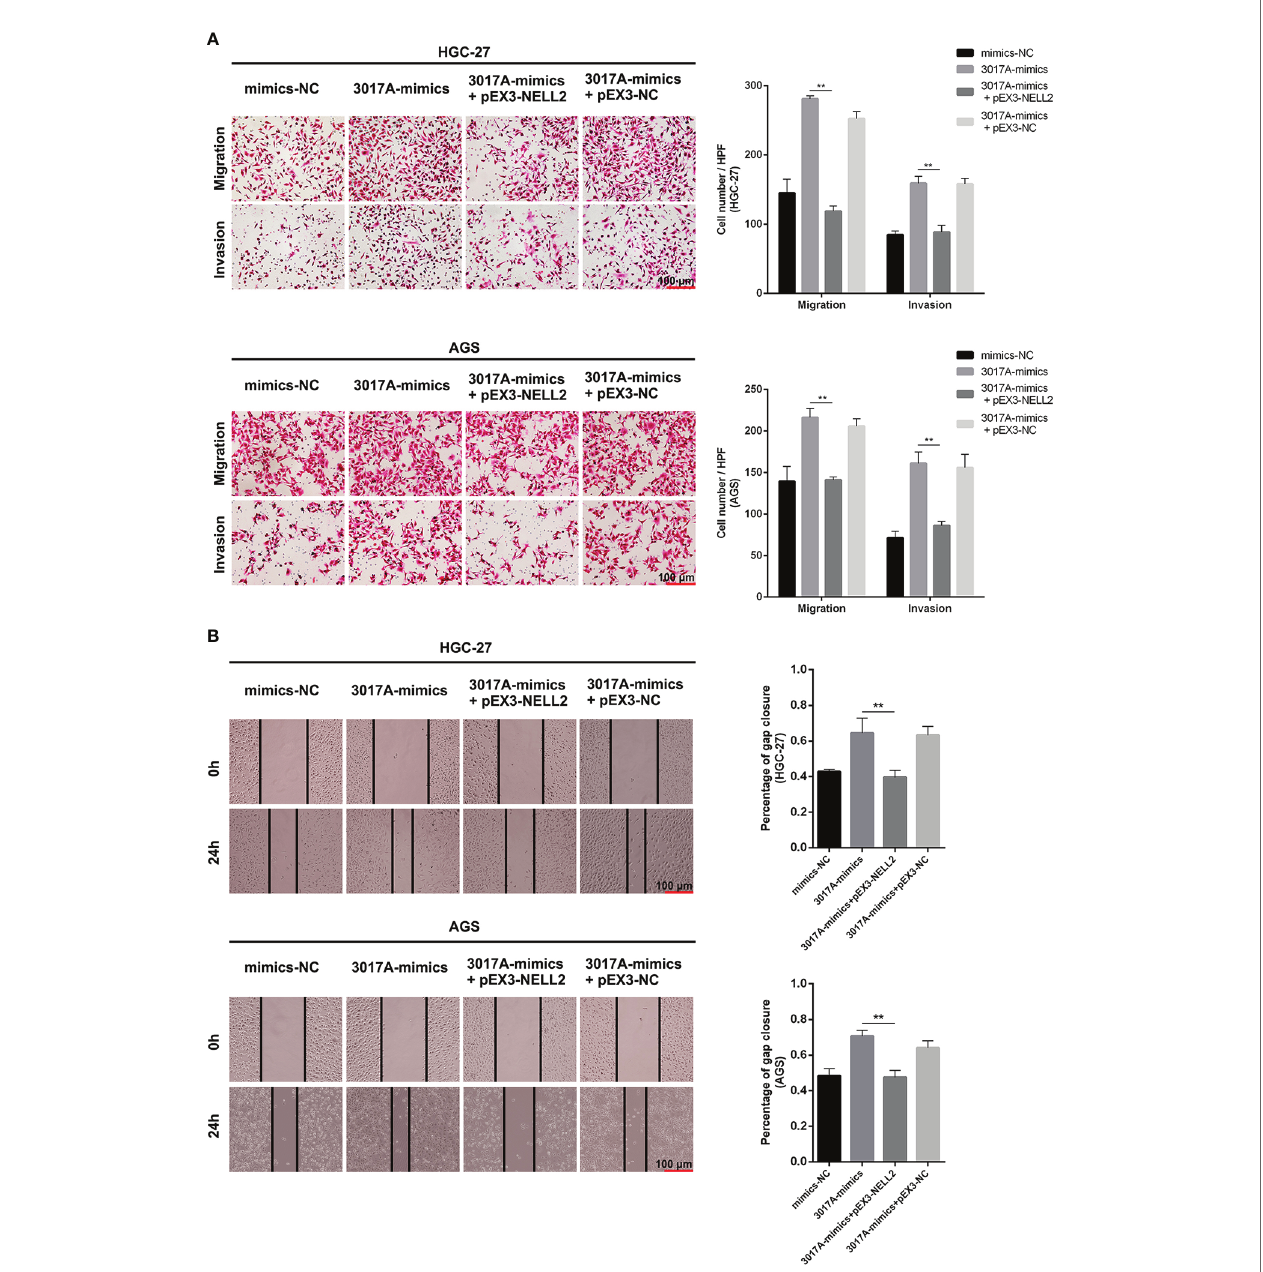
FIGURE 6 | Enhanced ability of migration and invasion induced by overexpression of tRF-3017A was restored by overexpressing NELL2. (A) GC cell migration and invasion ability were detected after co-transfected with tRF-3017A mimics and pEX3-NELL2. (B) The scratch wound healing assay was used to detect GC cell migration ability after co-transfection. Data are shown as mean ± SD. NC, negative control. **P <